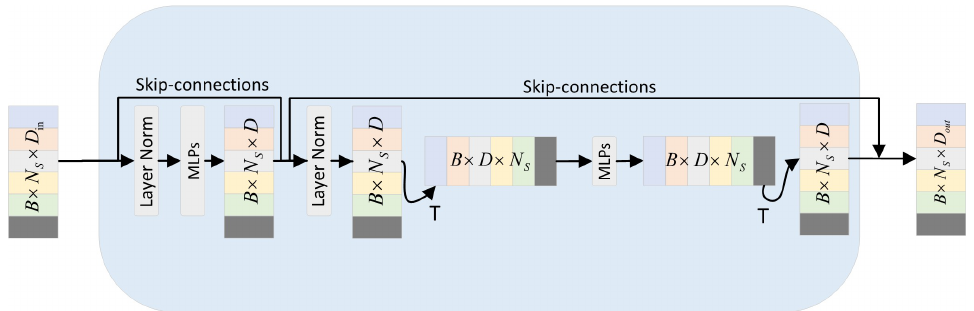
Figure 4. Point-mixer multi-level feature fusion